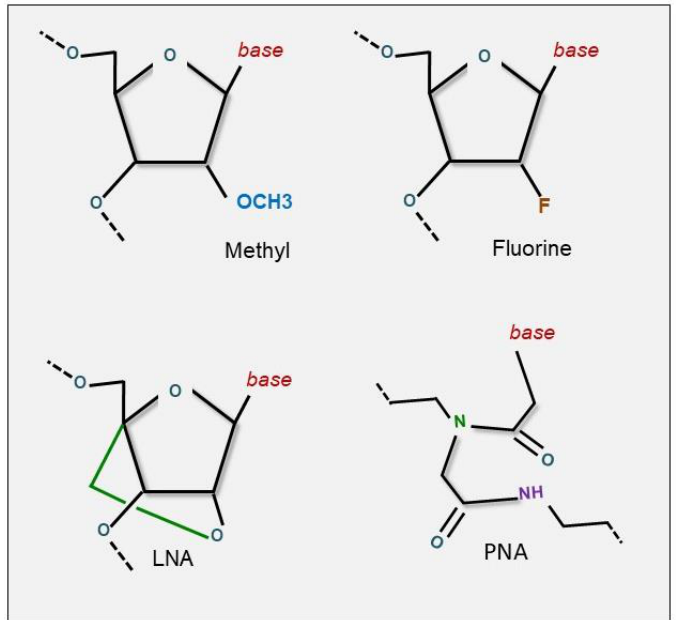
Figure 1. Different modifications to optimize oligonucleotides delivery. chemical modification of 2′-OH ribose with fluoro or methyl group results in oligonucleotide stabilization improving resistance to degradation in plasma. anti-miRNAs modified with LNAs (Locked Nucleic Acid) are more stable and have a high affinity with target miRNA. PNAs have their affinity to RNA than DNA and are very resistant to DNAses and proteases.